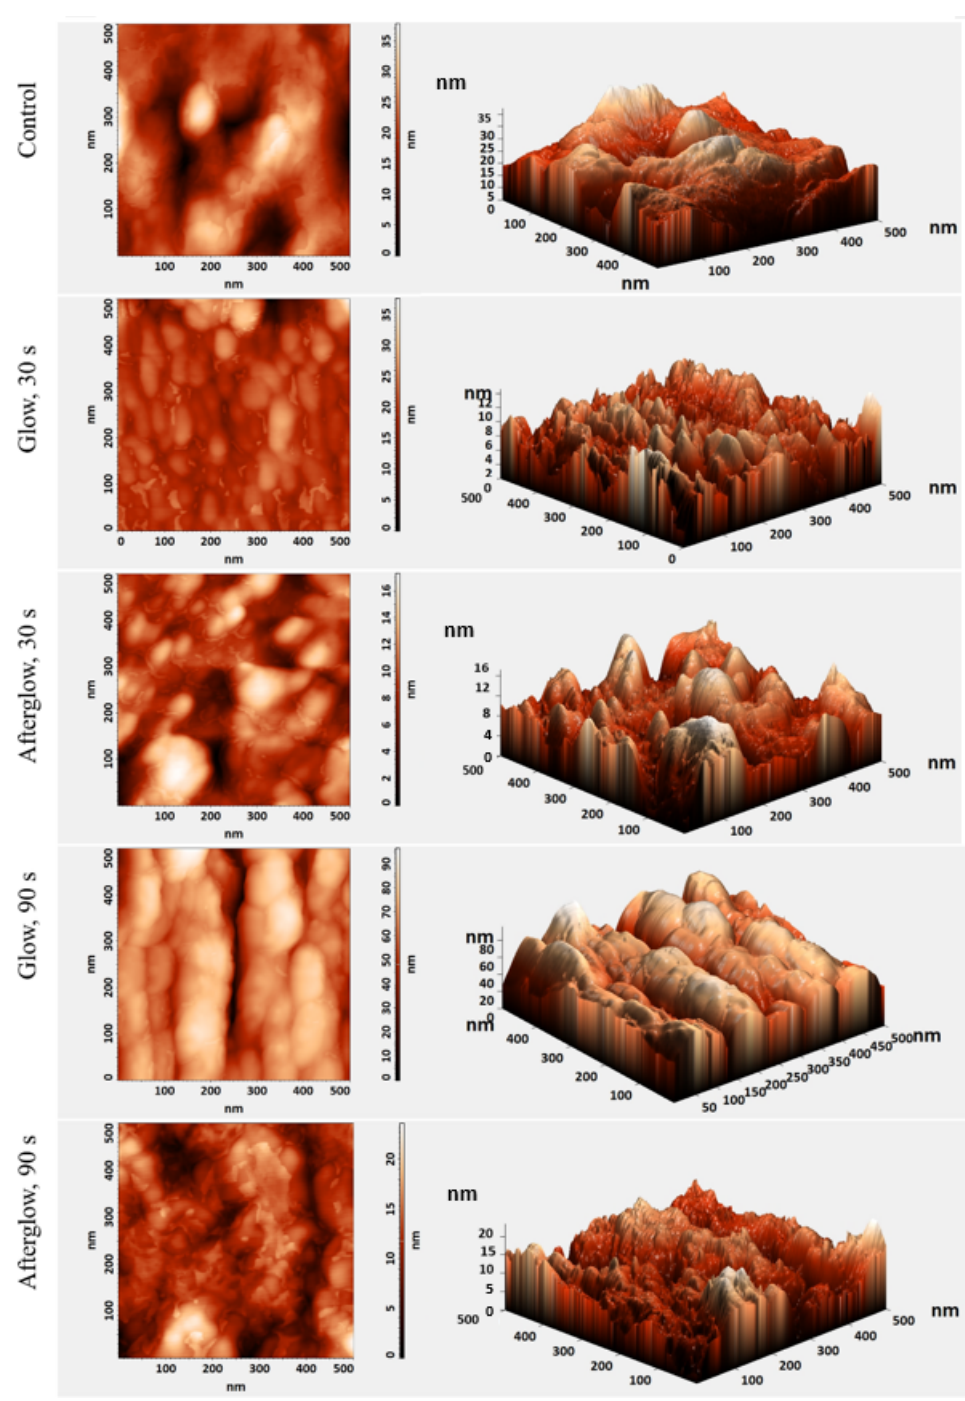
Figure A1. AFM images and 3D reconstruction of seed coat surface in untreated seeds and plasma- treated seeds in glow regime for 30 s and 90 s and afterglow plasma regime after 30 s and 90 s.